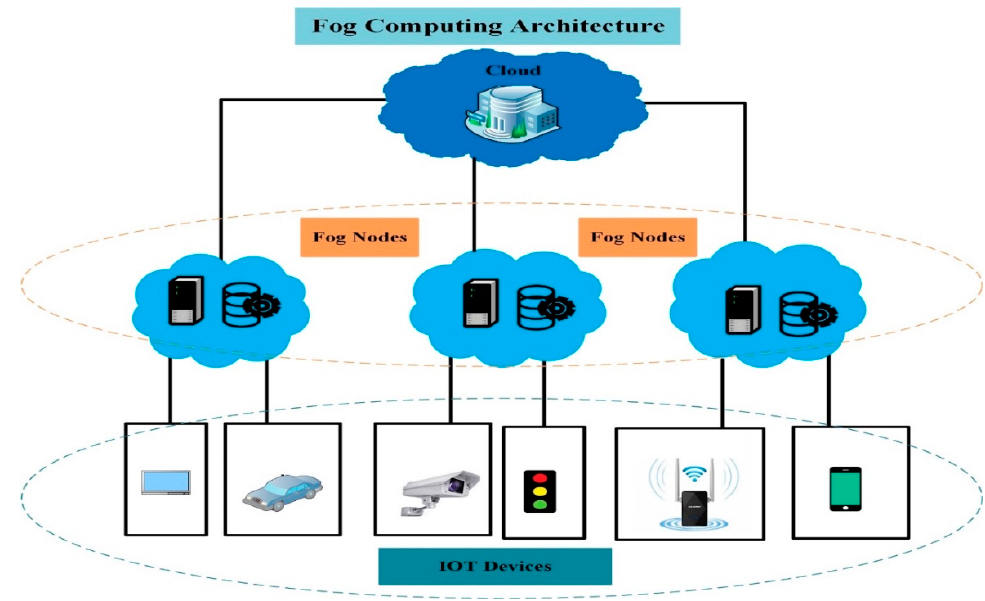
Figure 1. Fog computing: The general architecture [5] .